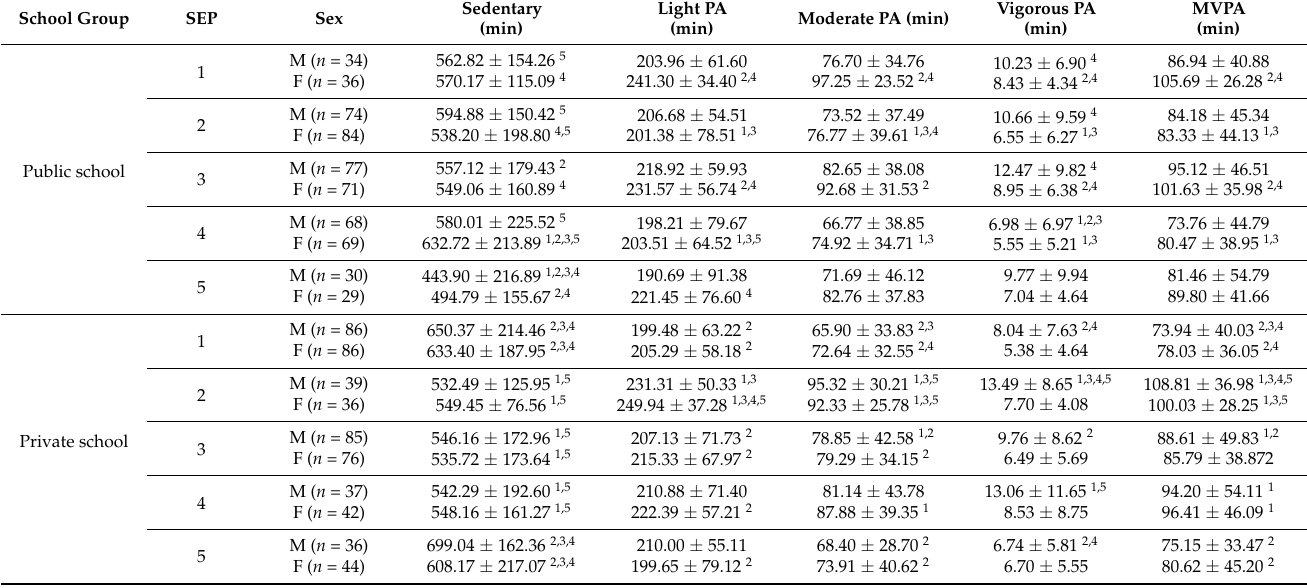
Table 8. Results of the daily PA analysis in each SEP level divided by sex and type of